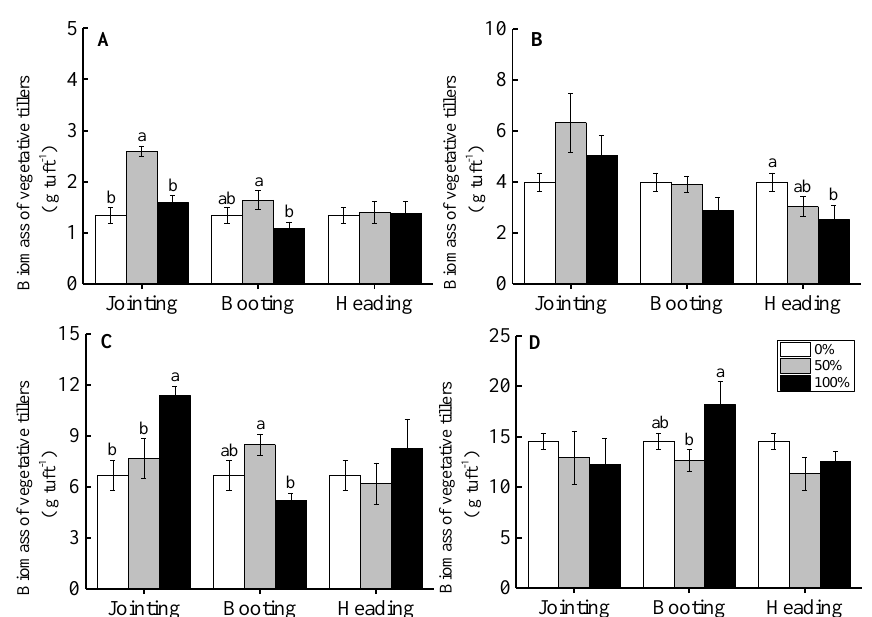
Figure 3. The effects of clipping intensity on the biomass of vegetative tillers of H. brevisubulatum of different grades when clipped at the jointing, booting, and heading periods. A , B , C , and D represent the grades (1, 2, 3, and 4, respectively) of the tuft diameters of H. brevisubulatum . Different lowercase letters represent significant differences among different clipping intensities ( p < 0.05). For grade 1 tuft diameters of H. brevisubulatum , compared to the non-clipped treatment, clipping increased the total number of juvenile tillers and buds and reached a significant level under 50% clipping treatments at the booting and heading periods, as shown in Figure 4A.